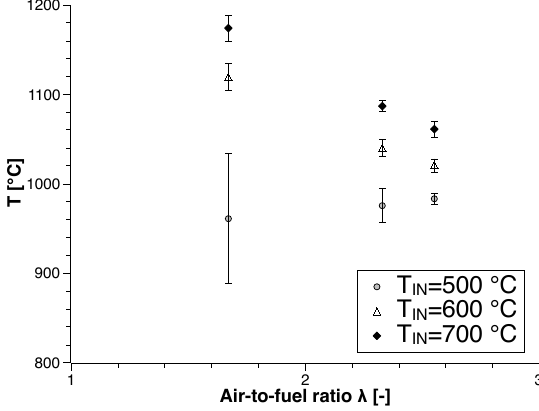
Figure 10. Exhaust gases temperature ( ◦ C) for different values of air–fuel equivalence ratios and different air inlet